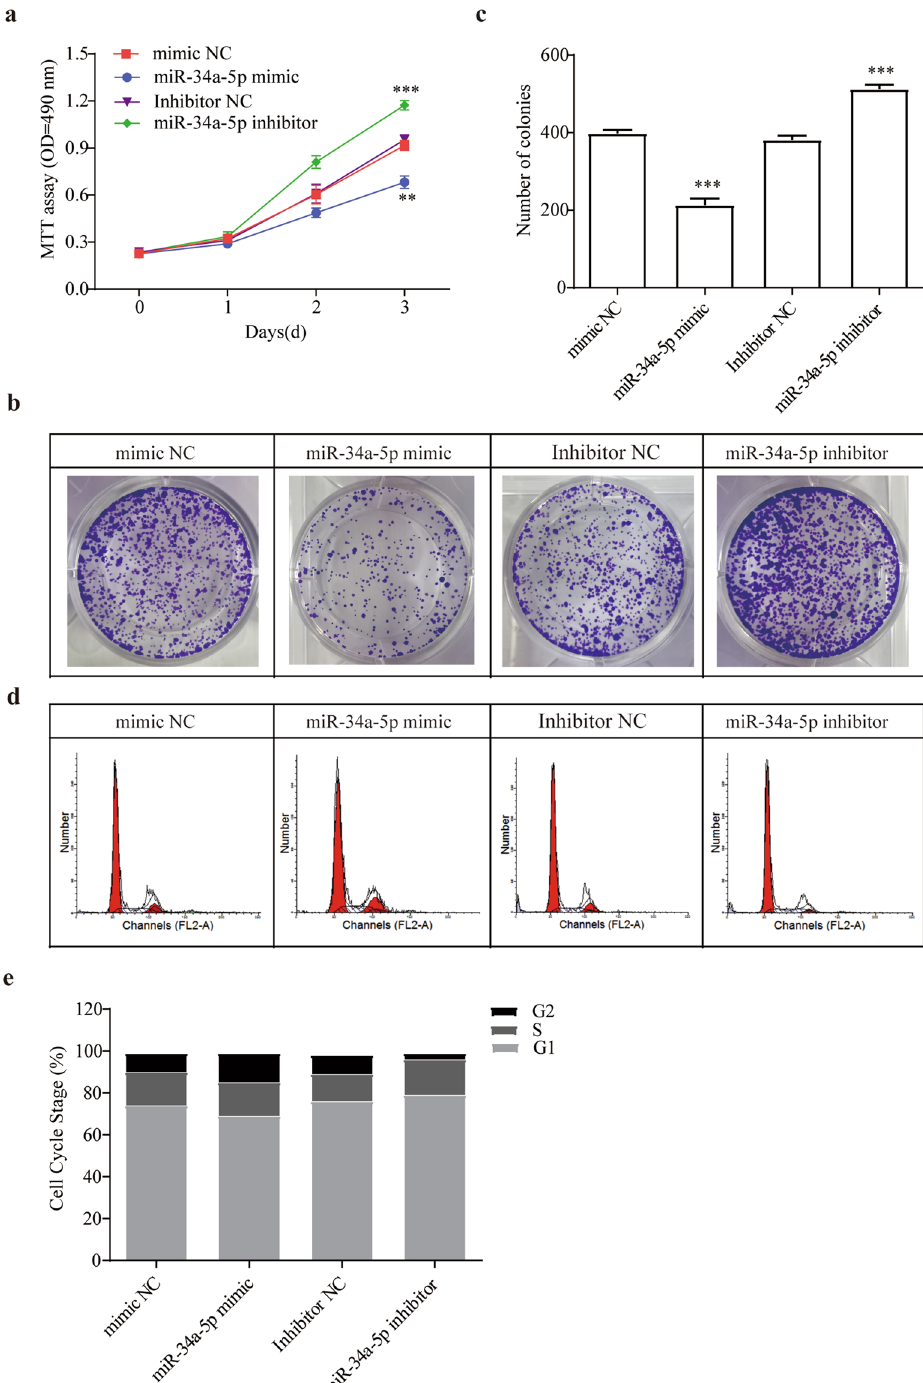
Figure 4. miR-34a-5p regulates lx-2 cell in proliferation, collagen precipitation and apoptosis. ( a ) Comparison of cell proliferation of HSCs transfected with miR-34a-5p mimic or inhibitor was determined by MTT assay. ( b ) Colony formation assay and ( c ) the quantification. ( d ) and ( e ) Cell-cycle distribution by flow cytometry, and statistical analysis of distribution of HSCs cell cycle